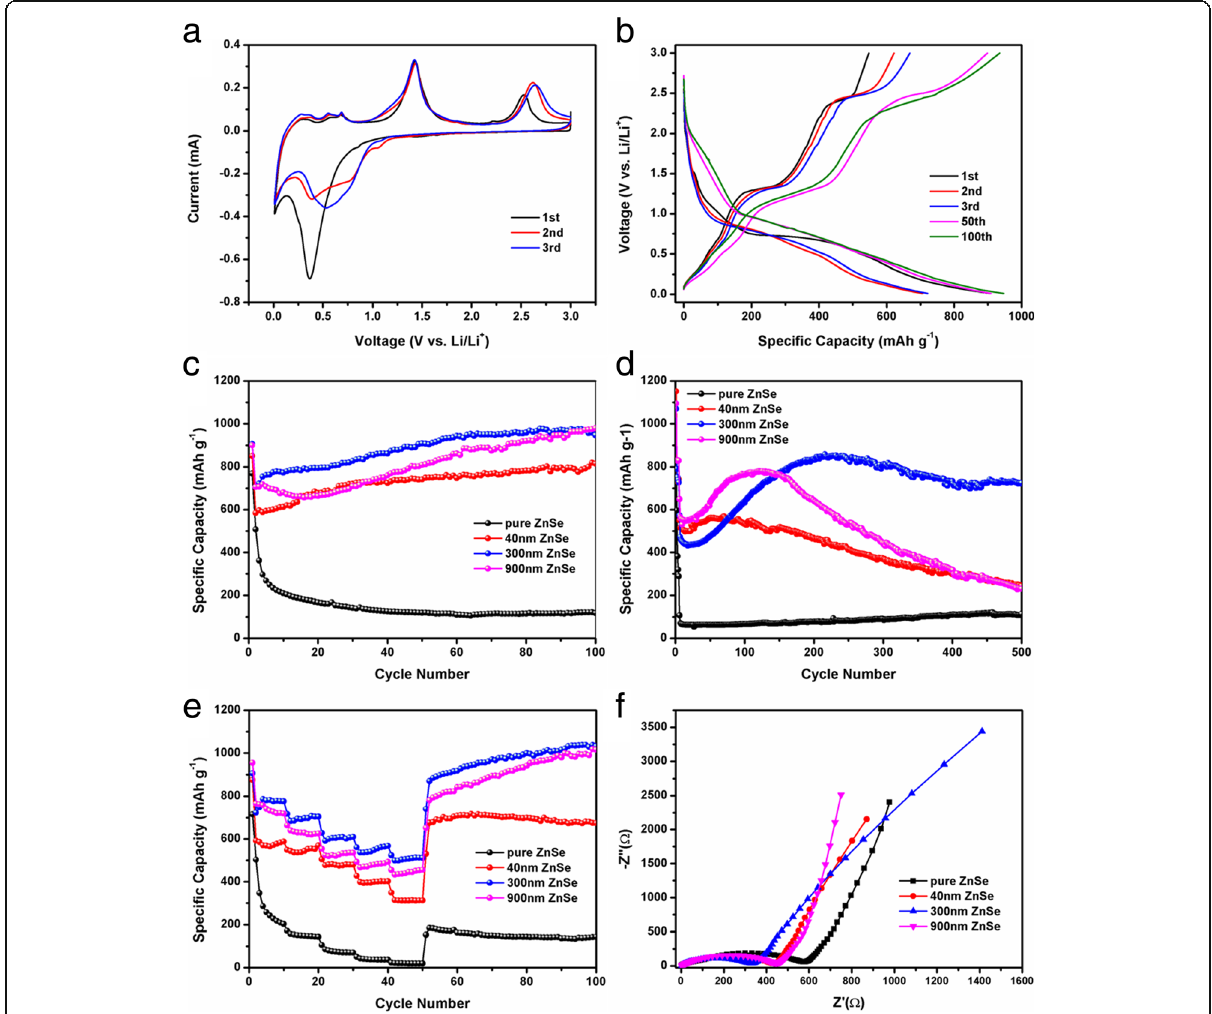
Fig. 6 a The first three cyclic CV cures of ZnSe/NC-300. b Galvanostatic charge-discharge curves at the current density of 100 mA g − 1 . c The cycling performance of pure ZnSe, ZnSe/NC-900, ZnSe/NC-300, and ZnSe/NC-40 at the current density of 100 mA g − 1 . d The cycling performance of pure ZnSe, ZnSe/NC-900, ZnSe/NC-300, and ZnSe/NC-40 at the current density of 1 A g − 1 . e Rate performance of pure ZnSe, ZnSe/NC-900, ZnSe/NC-300, and ZnSe/NC-40 at the current densities ranging from 0.1 to 2 A g − 1 . f EIS spectra of pure ZnSe, ZnSe/NC-900, ZnSe/NC-300,